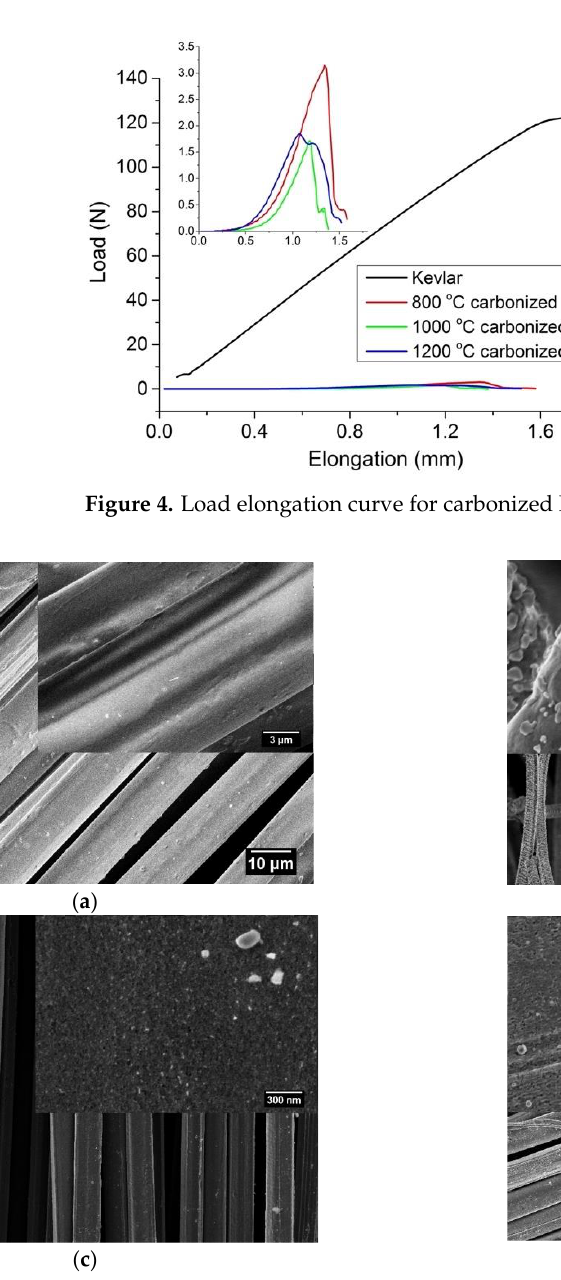
Figure 5. Microstructure of Kevlar fibers after different carbonization temperatures. ( a ) Kevlar fabric; ( b ) activated carbon fabric at 800 °C; ( c ) activated carbon fabric at 1000 °C; and ( d ) activated carbon fabric at 1200 °C.